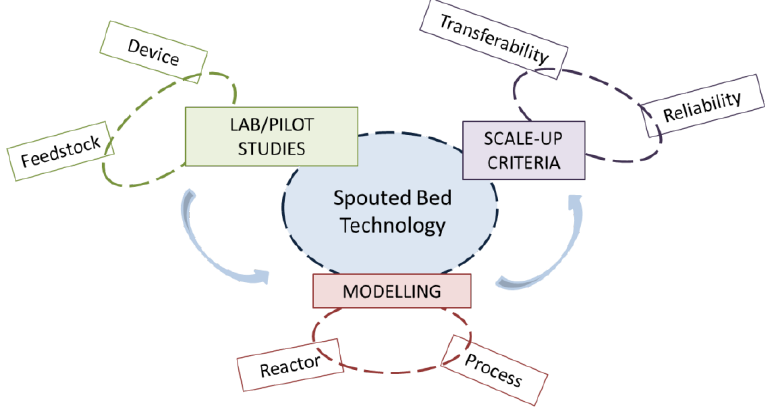
Figure 4. Levels of development of SB technology.